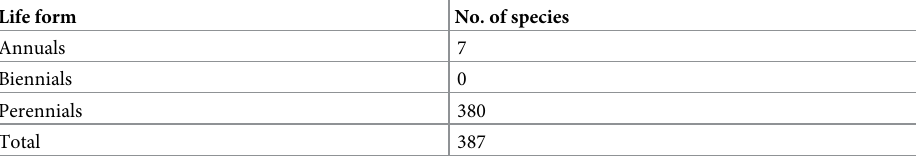
Table 2. Counts of life histories of endemic plants in Hainan. Life form